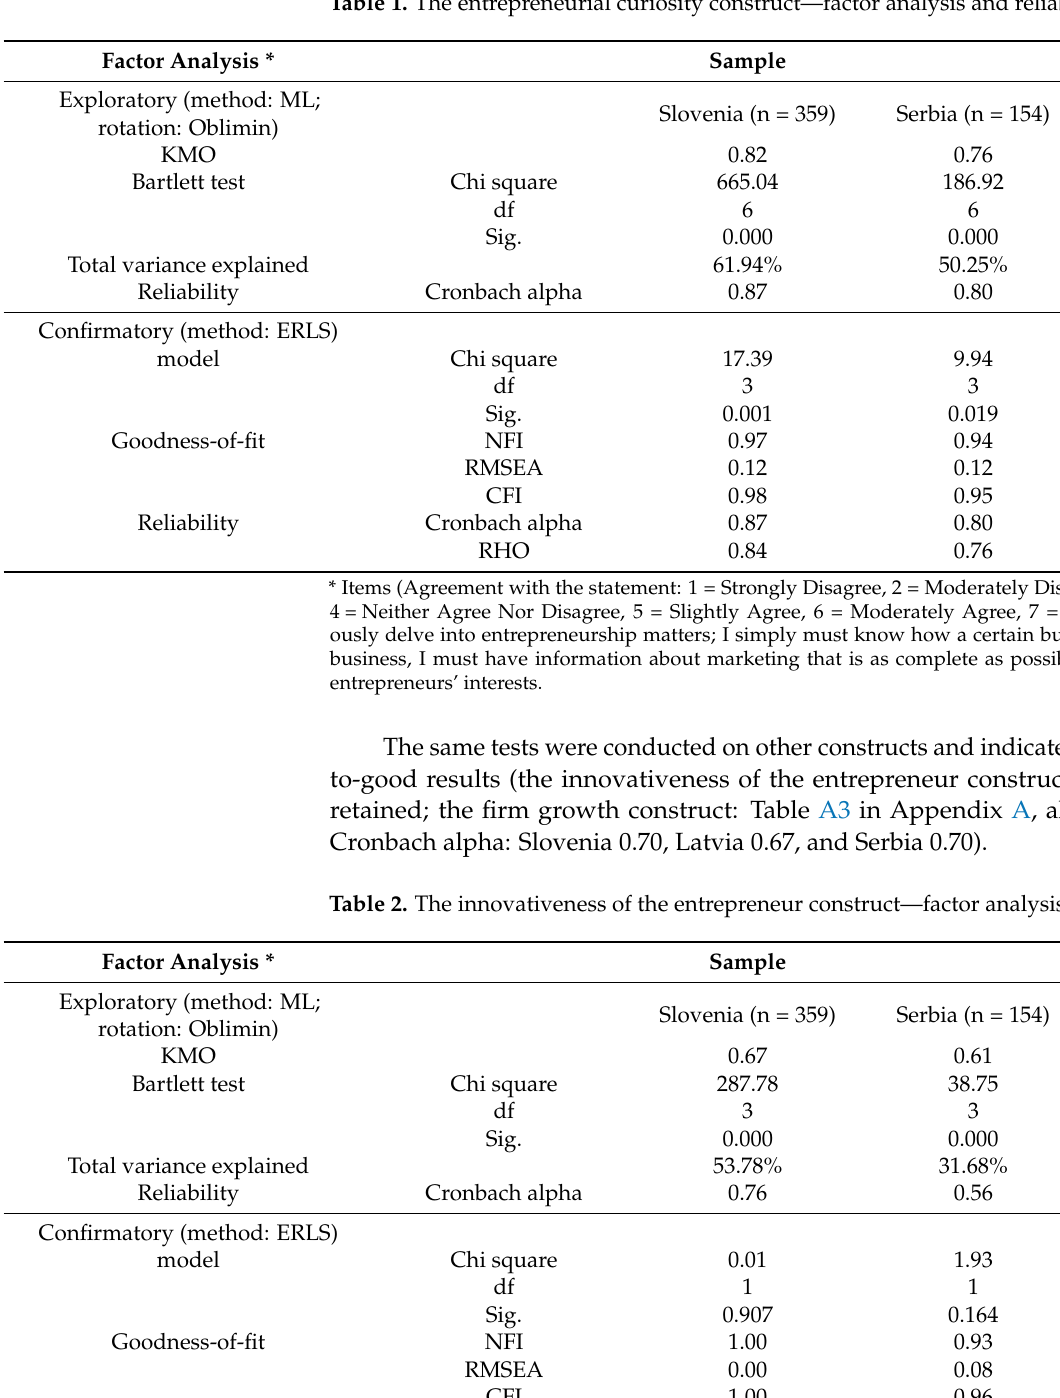
Table 1. The entrepreneurial curiosity construct—factor analysis and reliability results.